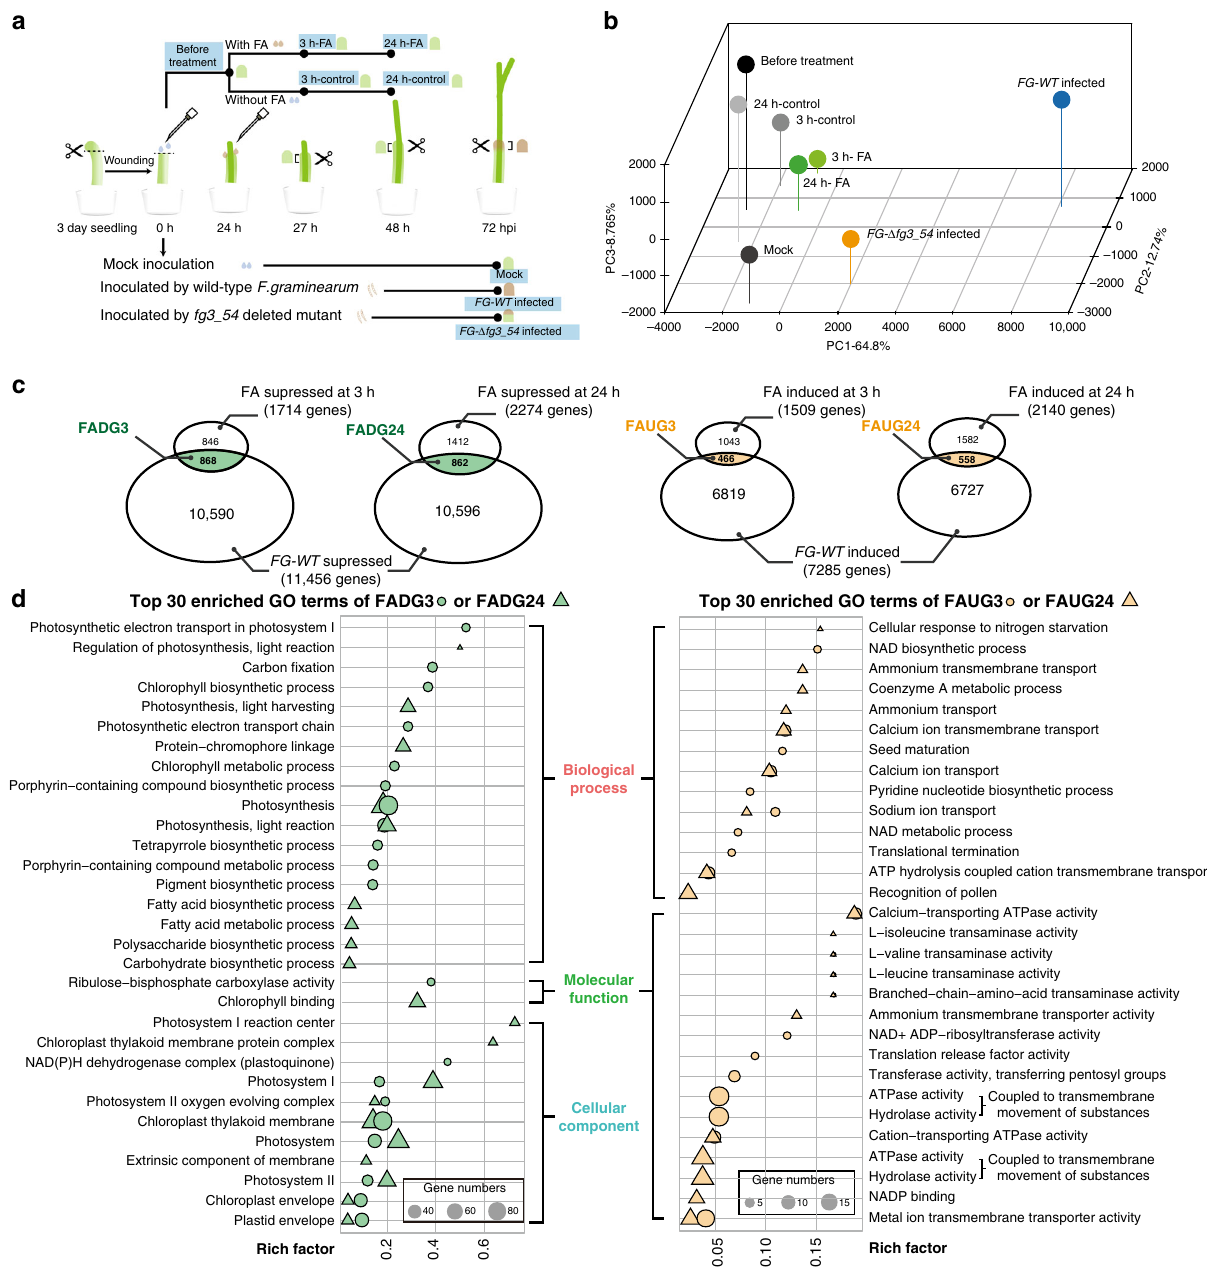
Fig. 9 RNA sequencing analysis of wheat gene responses to fusaoctaxin A. a Schematic diagram of RNA-seq sample arrangements. The sample names are highlighted in the blue background. 3 h-FA and 24 h-FA: wheat coleoptiles collected at 3 h and 24 h, respectively, after treatment with 1 nmol fusaoctaxin A in 0.5% Tween-20 water solution (2 μ L per seedling). 3 h-control and 24 h-control: wheat coleoptiles collected at 3 h and 24 h, respectively, after treatment with 0.5% Tween-20 water solution (2 μ L per seedling). b Principal component analysis of the wheat transcriptomes of